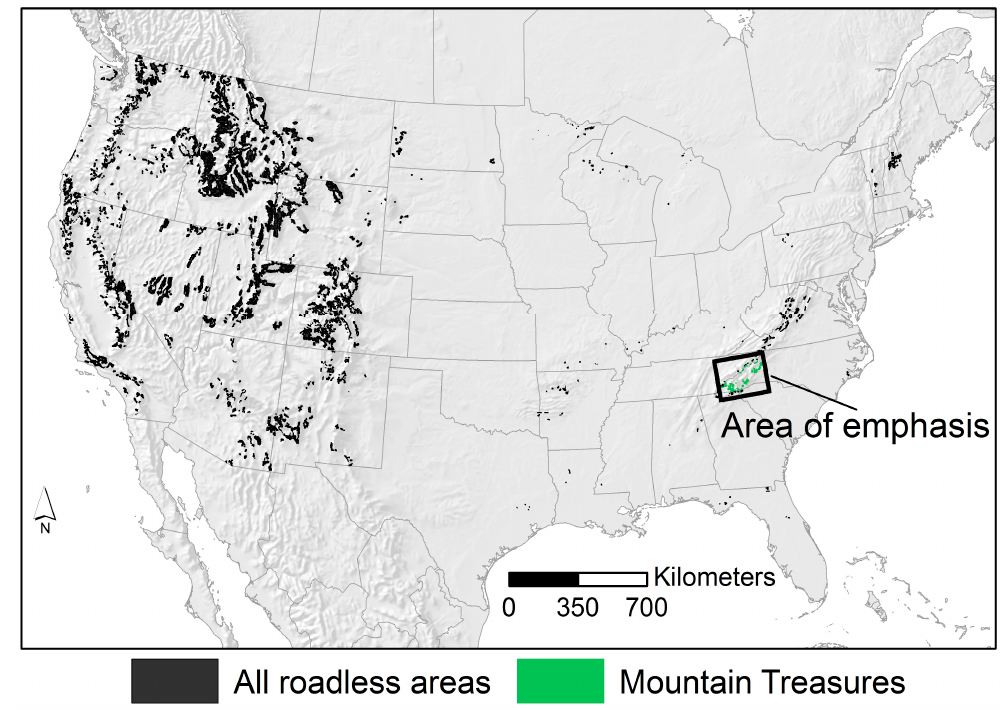
Figure 1. The location of Mountain Treasures (green) and all other roadless areas (grey) in the contiguous United States. The maps in Figures 3–7 represent the “area of emphasis” highlighted here.